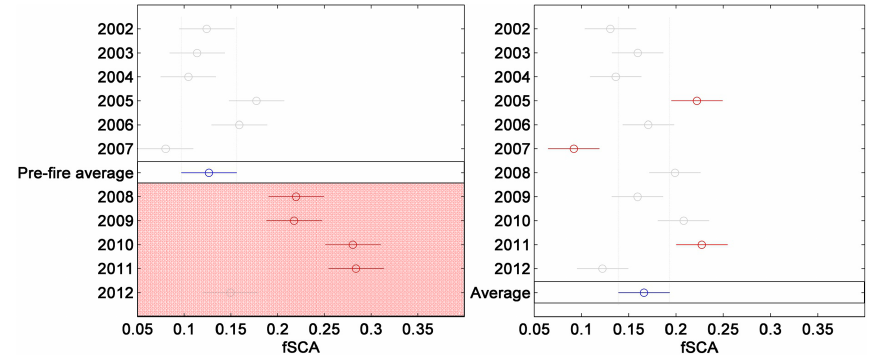
Figure 7. Basin-averaged ANOVA results for the Moonlight Fire area (left) and Grizzly Ridge (right) (99% confidence interval). The post-fire years are shaded for the Moonlight Fire area. Table 3. ANOVA results based on basin attributes for area of the Moonlight Fire. Bold font denotes statistical significance ( P < 0 . 01), post-fire years are set italic. Slope